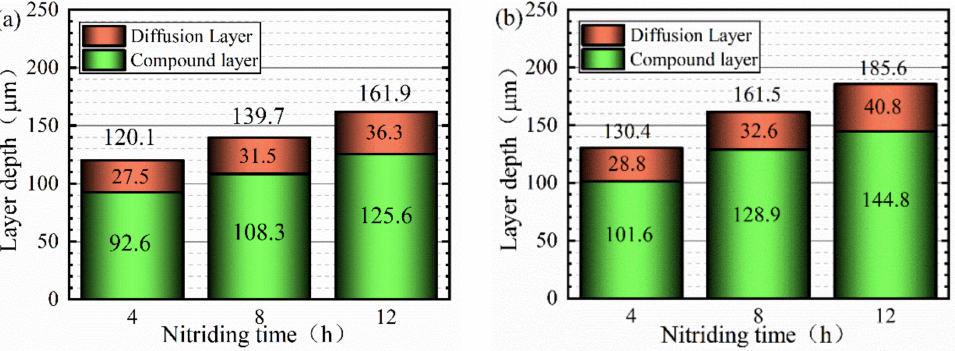
Figure 2. Thickness of modified layer section of 3Cr13 steel after plasma nitriding at different times ( a ) Without RE ( b ) With RE. Figure 3a,b are histograms of the weight gain of 3Cr13 steel after plasma nitriding for